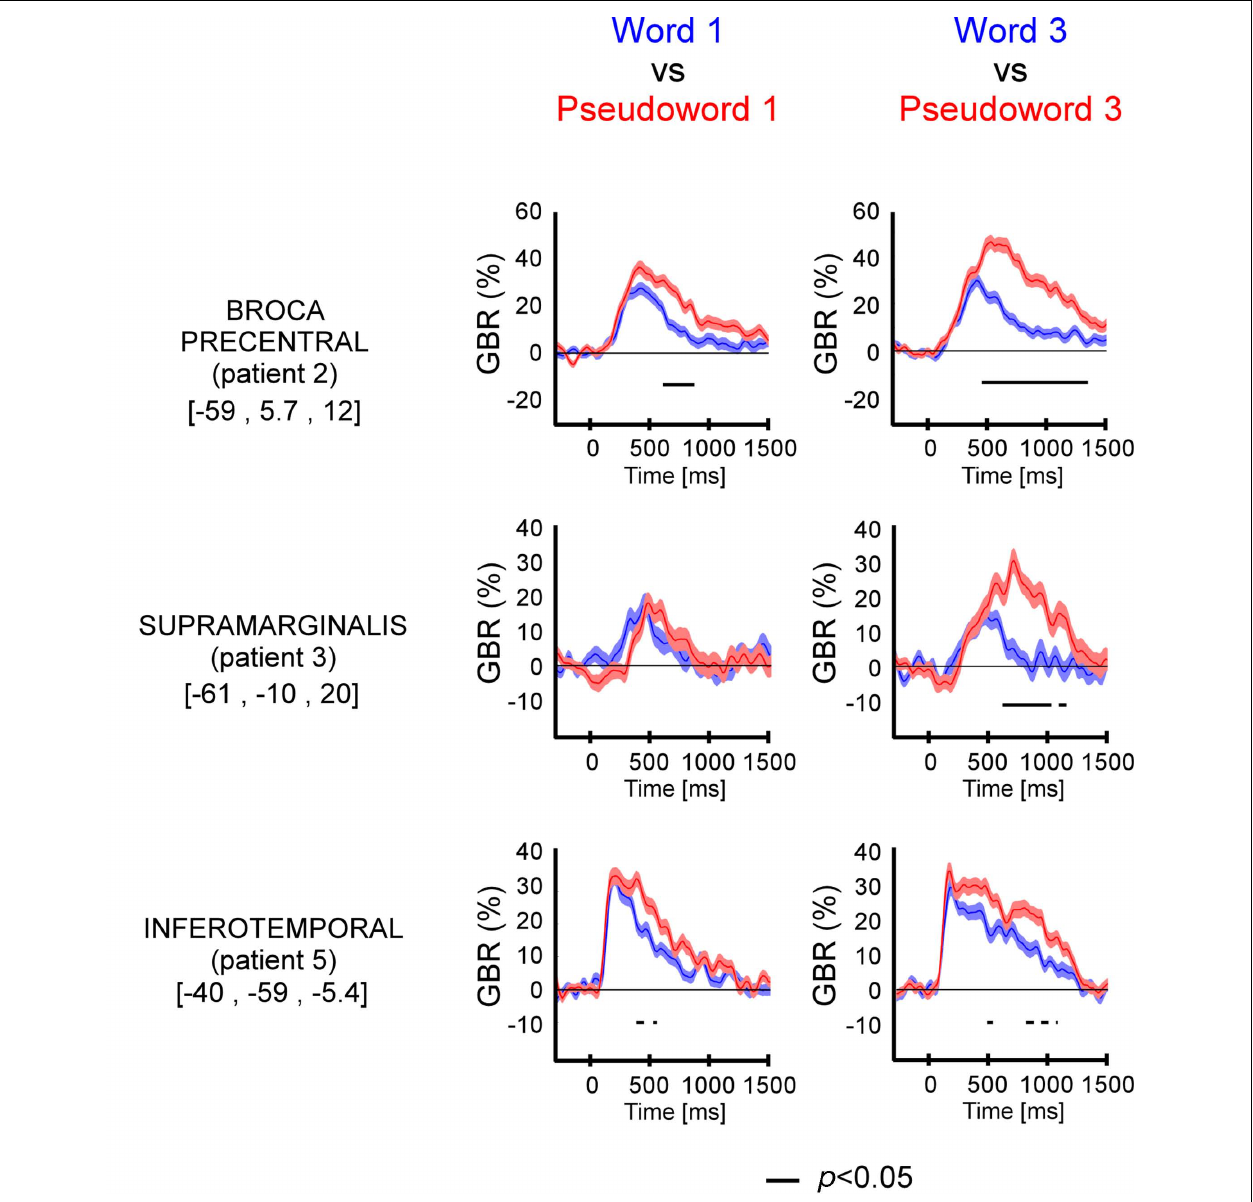
different ( p < 0.05, Kruskal–Wallis, FDR corrected for multiple comparisons). Compared to short, long pseudo-words showed significant effect in all three regions. No length effect was observed for words. For each region the Talairach coordinates are